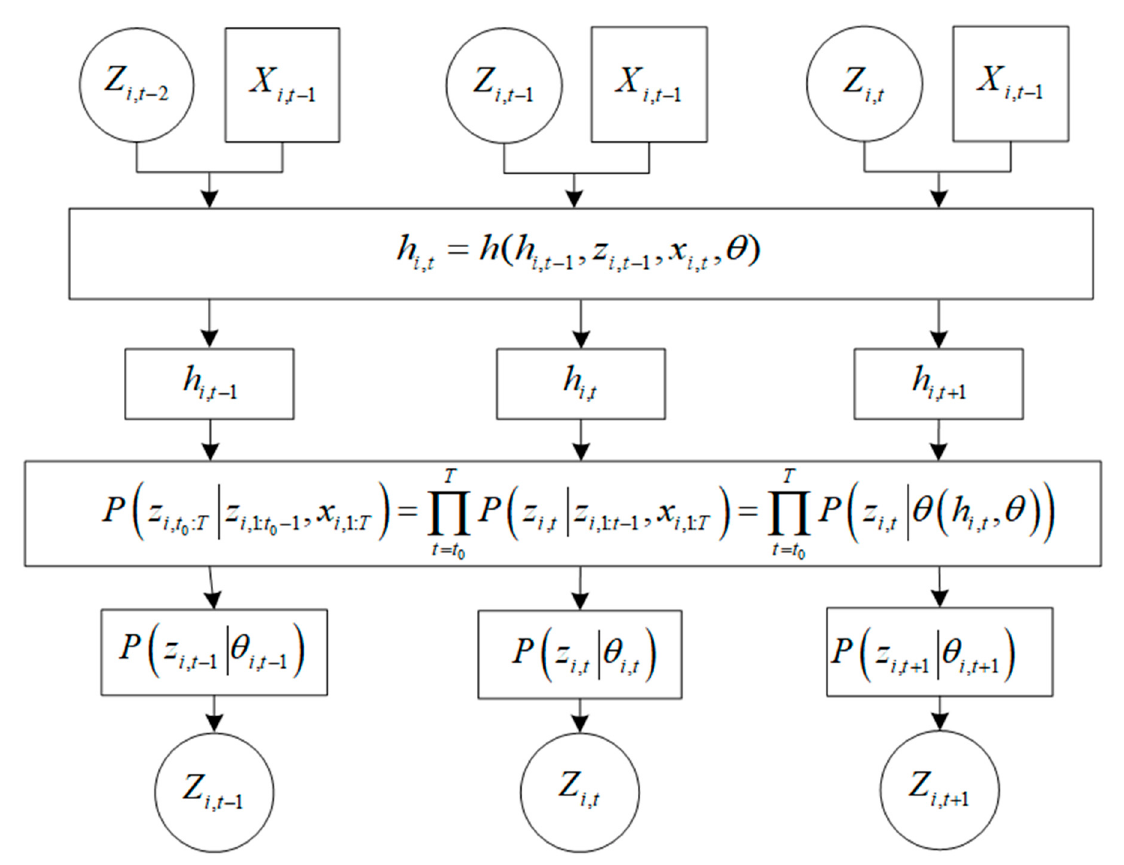
Figure 2. Process of DeepAR in conditioning range. At each time point t , the inputs of DeepAR model are x i , t , z i , t − 1 and h i , t − 1 , where h i , t − 1 is the previous output of neural network, x i , t is the value of covariates at time t , z i , t − 1 is the target value at time t − 1. The value of z i , t − 1 is available during conditioning range and is used to train the model. The z i , t − 1 is unknown during prediction range, and z i , t − 1 is replaced by (cid:101) z i , t − 1 when DeepAR is utilized to achieve multi-step